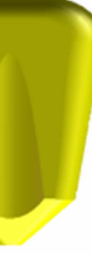
Figure 6. Three-dimensional model of corn seed.